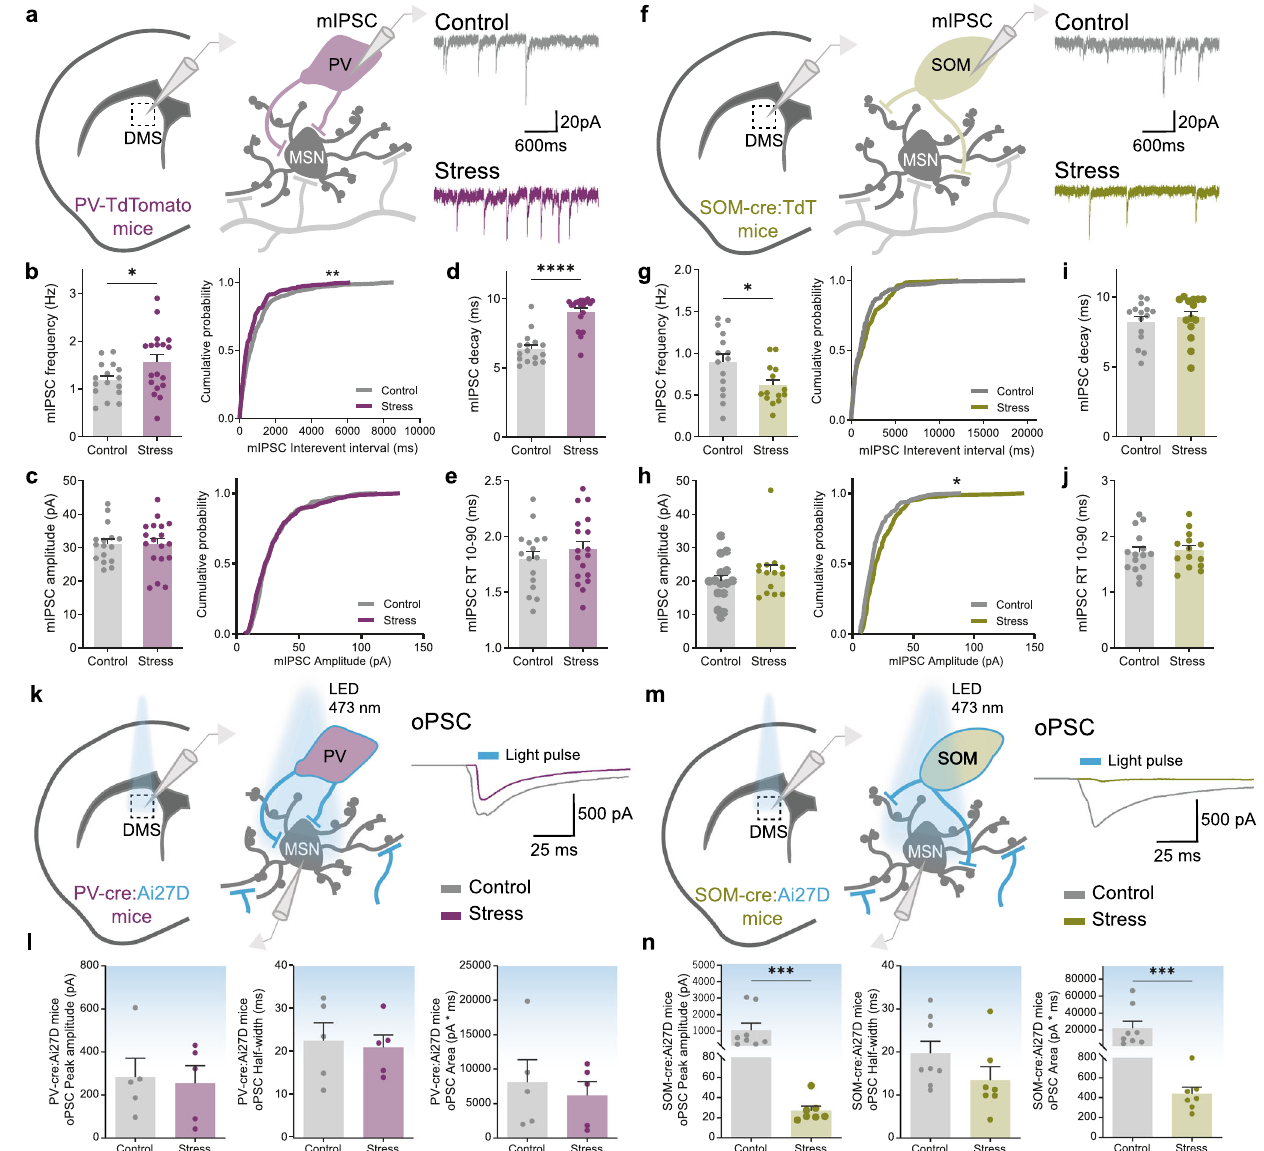
Fig.4|StriatalSOMinterneuronsaremajortargetsofchronicstress.a Example traces of miniature inhibitory postsynaptic currents (mIPSCs) recorded from PV interneurons in dorsomedial striatum region (DMS) of control (gray) and stressed (purple) mice. b Summary bar graphs (control n =16 and stress n =18 cells; * p =0.0387) and cumulative probability curves (20 events per cell; ** p =0.0019) showincreasedmIPSCfrequencyinPVinterneuronsofstressmice. c Summarybar graphs(control n =16andstress n =18cells)andcumulativeprobabilitycurves(20 events per cell) show similar mIPSC amplitude in PV interneurons of stress mice; d , e Summary bar graphs (control n =16 and stress n =18 cells) show signi fi cantly slower mIPSCs decay kinetics in PV interneurons of stress mice (**** p <0.0001), with similar rise times (RT). f Example traces of mIPSCs recorded from SOM interneuronsinDMSregionofcontrol(gray)andstressed(green)mice. g Summary bar graphs (control n =15 and stress n =14 cells; * p =0.0228) and cumulative probability curves (10 events per cell) show decreased mIPSC frequency in SOM interneuronsof stressmice. h Summarybargraphs(control n =15and stress n =14 cells) and cumulative probability curves (10 events per cell) show trend for increased mIPSC amplitude in SOM interneurons of stress mice. i , j Summary